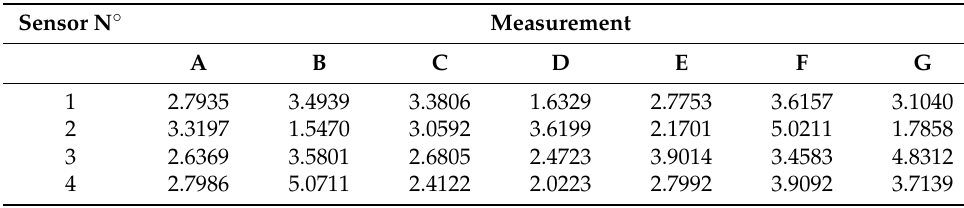
Table 9. RMS of frequency spectrum (10 − 3 ), slab with no